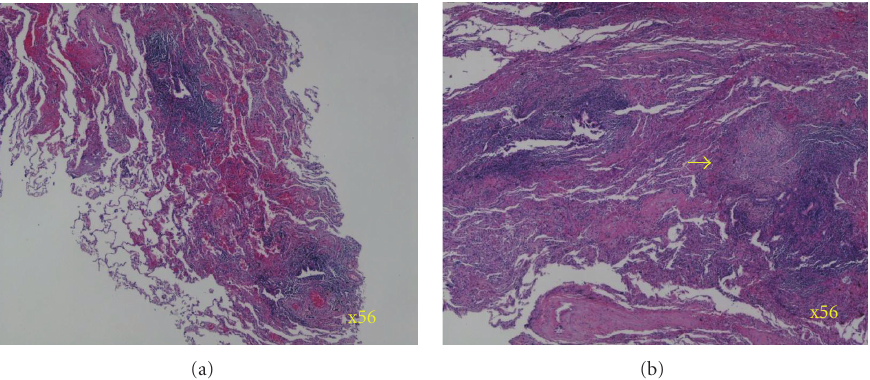
Figure 2: Lung biopsy stained with hematoxylin-eosin showed many areas of follicular bronchiolitis characterized by the presence of hyperplastic lymphoid follicles distributed along the bronchioles and few granulomas (arrow) (original magnification ×